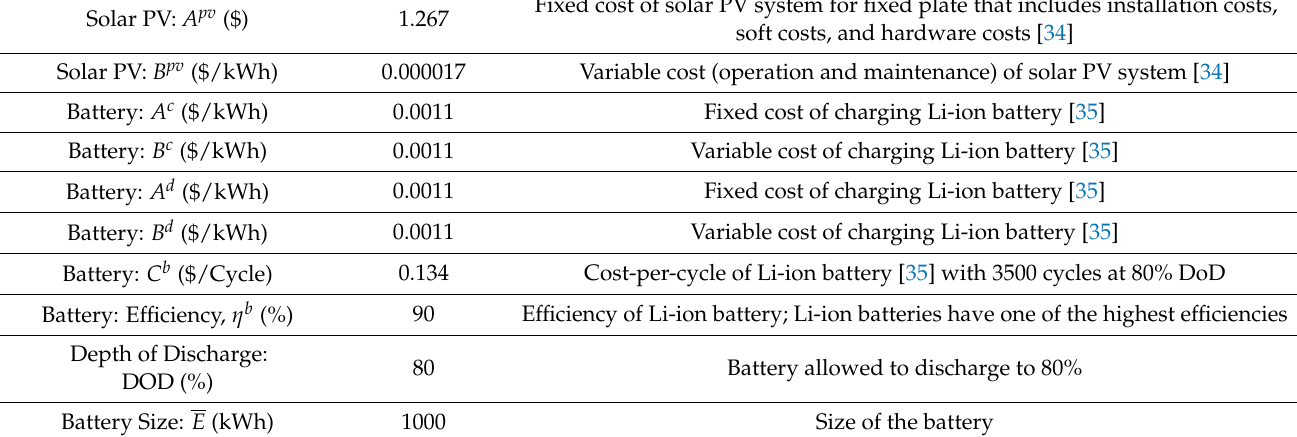
Table 1. Costs and other data for solar PV and